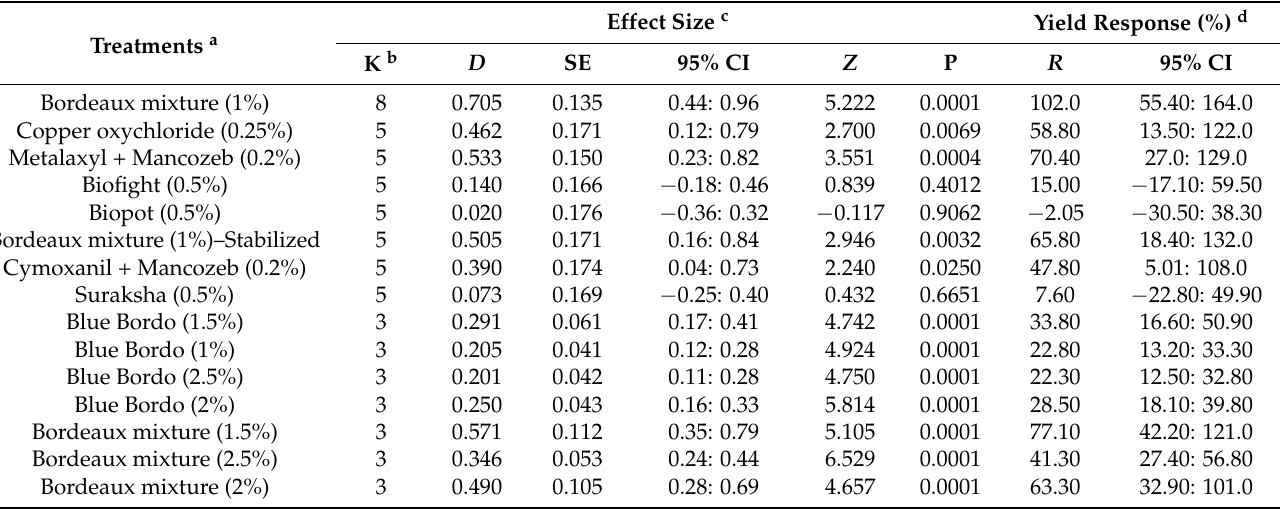
The network meta-analysis model fitted the data collected from the field trials carried out under multi-location conditions in India. a Active ingredients of the evaluated treatments for FRD in arecanut. b The number of trials selected for each specific treatment and untreated controls. c Mean yield difference ( D , kg/palm) for each treatment corresponding to the untreated check; standard error (SE) of D and 95% confidence interval (CI) around D ; Z (standard normal) statistic from the network meta-analytical model; p = probability value (level of significance). d Average yield response ( R ) computed by back-transformation of estimated FRD incidence and 95% CI (lower and upper limits) containing R ; Test for Residual Heterogeneity; QE (df = 56) =